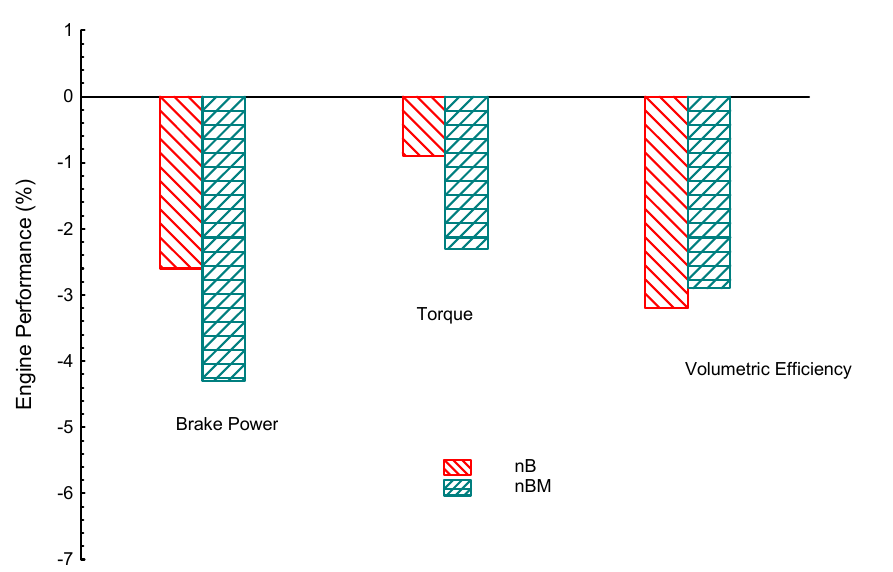
Figure 9. Comparisons of brake power, volumetric efficiency and torque for n-butanol–methanol (nBM) and n-butanol (nB) blended with gasoline and neat gasoline (baseline) in %.